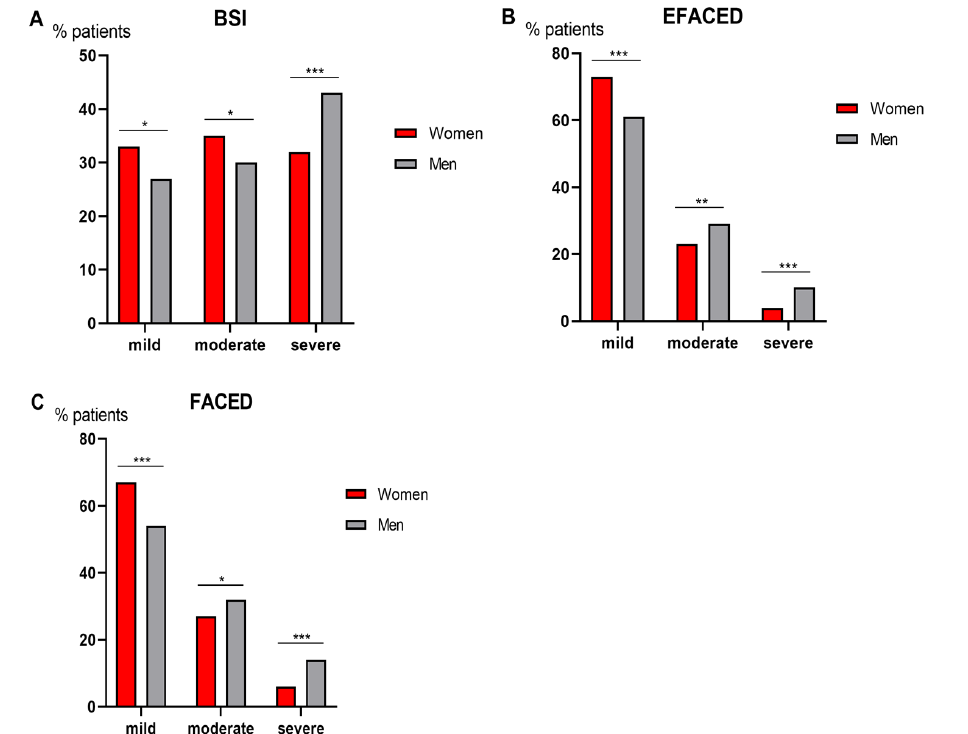
Figure 2. In all the patients as a whole, histograms of the proportions of patients who were classified as mild, moderate, or severe according to BSI ( A ), EFACED ( B ) and FACED ( C ) for both female (red color) and male (grey color) patients. Score subdivisions were as follows: (1) BSI: mild: 0–4, moderate: 5–8, severe: ≥ 9, (2) EFACED: mild: 0–3, moderate: 4–6, severe: 7–9; and (3) FACED: mild: 0–2, moderate: 3–4, severe: 5–7. Statistical significance: * p ≤ 0.05; ** p ≤ 0.01; *** p ≤ 0.001 between female and male patients for each score.